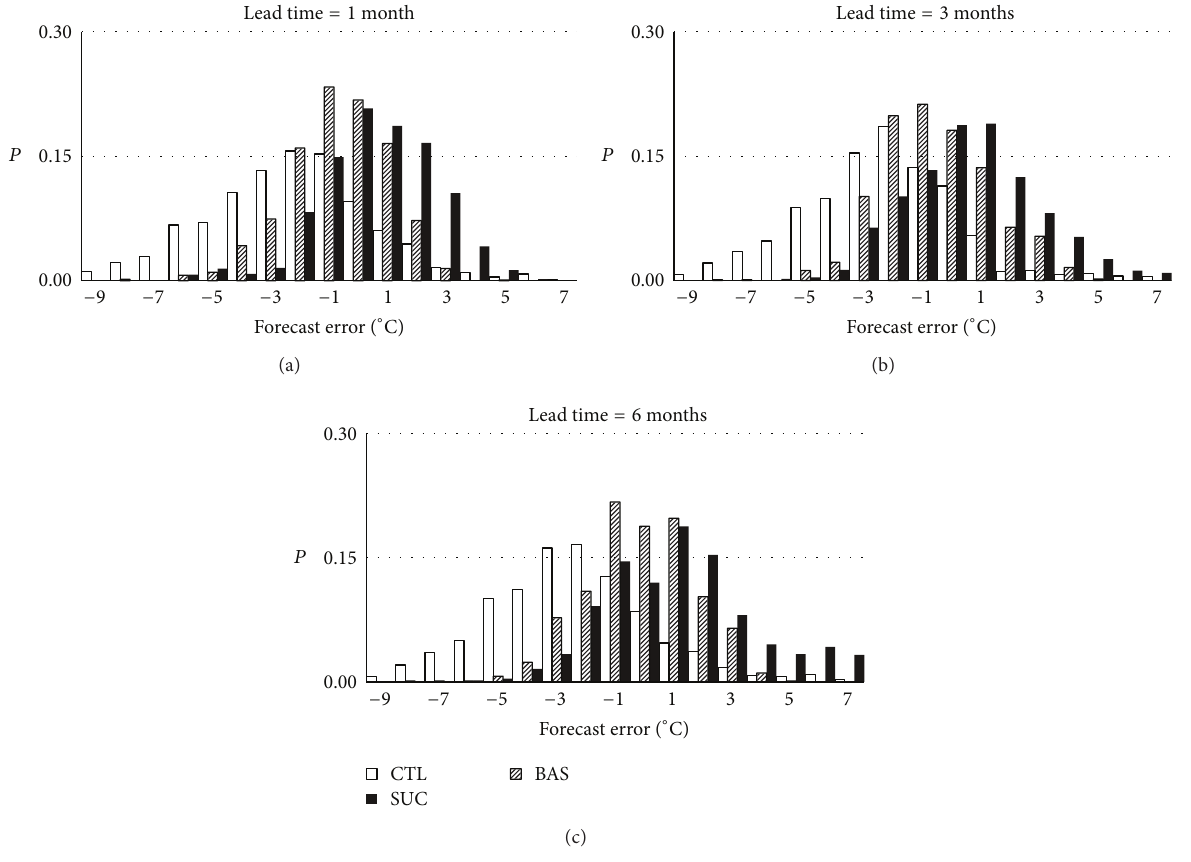
Figure 9: Frequency distributions ( 𝑃 ) of the Tx forecast errors ( ∘ C) for lead times of 1 month (a), 3 months (b), and 6 months (c).